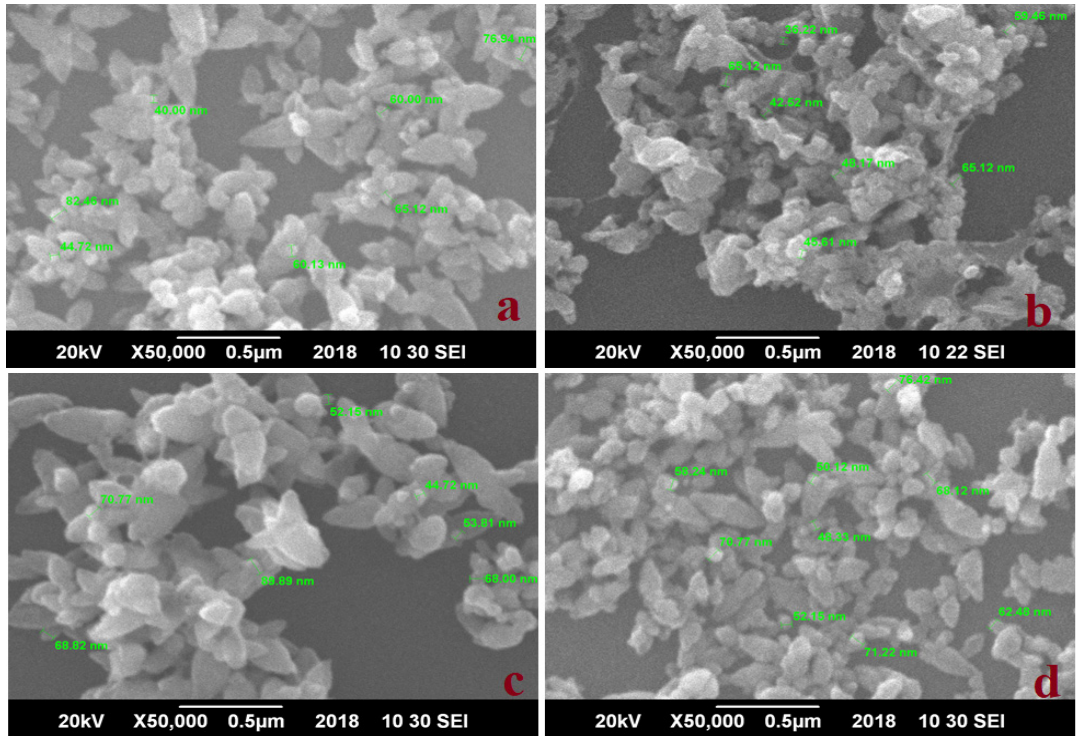
Figure 2. SEM images of ( a ) W-ZNPs, ( b ) P-ZNPs, ( c ) C-ZNPs and ( d ) S-ZNPs.